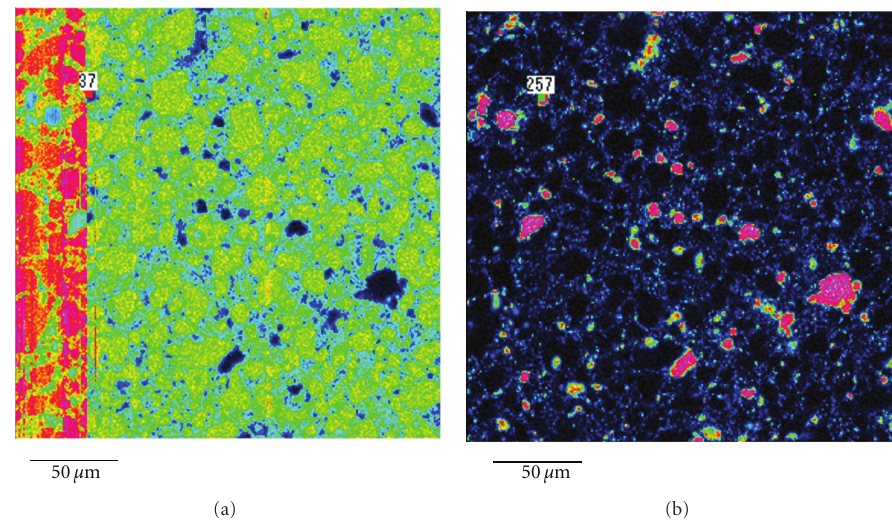
Figure 4: Elemental quantity mapping analysis for (a) Ni and (b) Co over a 230 × 230 μ m 3 area for the x = 0 . 25 sample with an acceleration voltage of 15 kV and probe diameter of 1 μ m. The red-colored area on the left side of Figure 4(a) is due to instrumental noise.